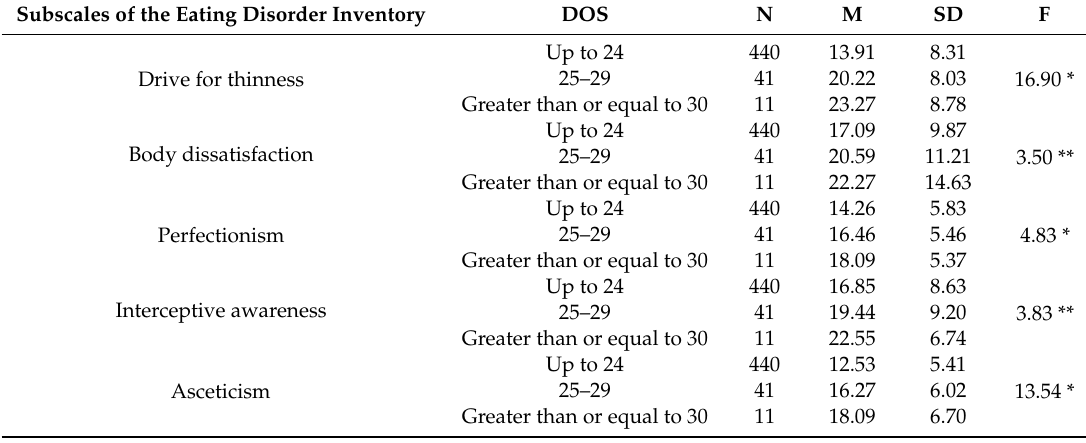
Table 2. Analysis of Variance between (DOS) and subscales of the Eating disorder Inventory (EDI-2). Subscales of the Eating Disorder Inventory